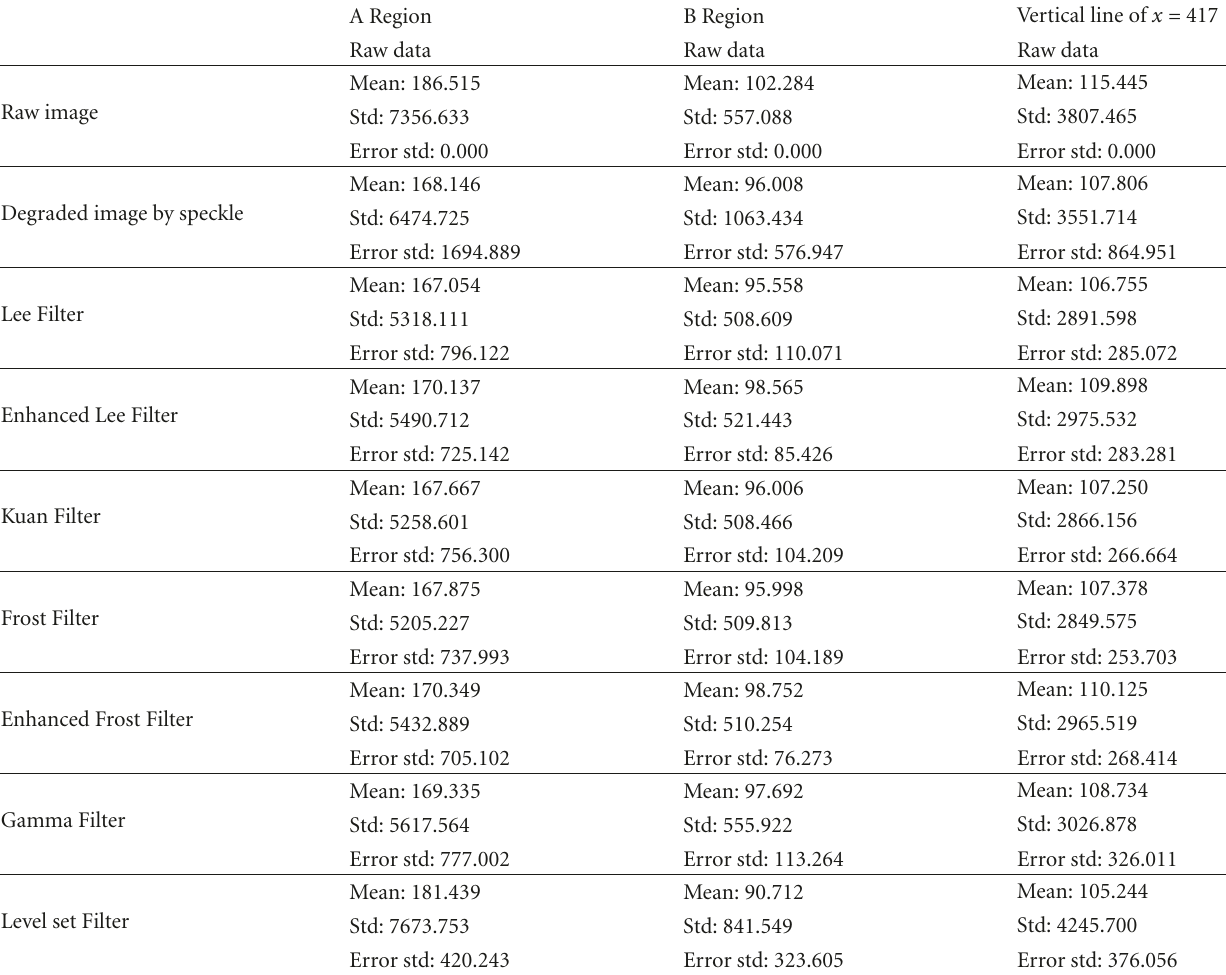
Table 1: Mean, standard deviation and error standard deviation for regions A, B, and C. A Region B